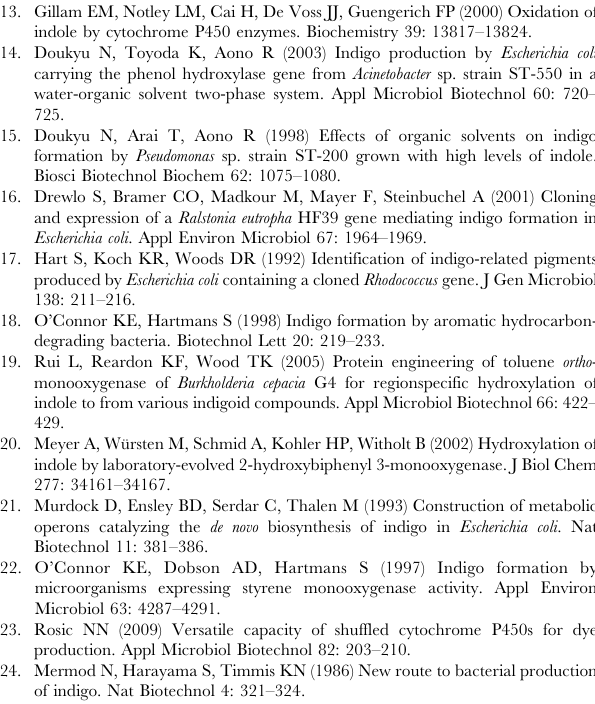
Figure S6 SDS-PAGE analysis of protein samples of strain PH_ IND and its mutants. Line 1. Cell extracts of strain